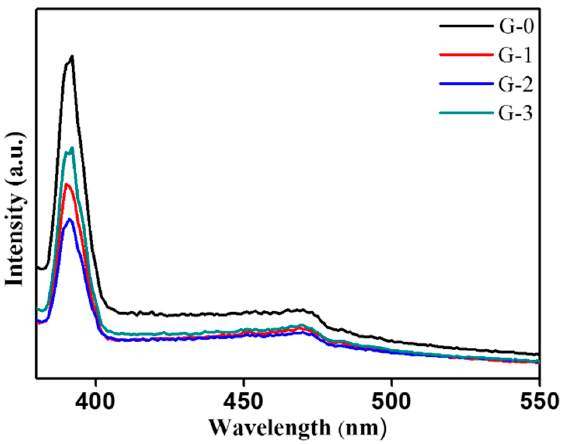
Figure 3. Photoluminescence spectra of pure TiO 2 (G-0), Cu-TiO 2 (G-1, G-2, and G-3).